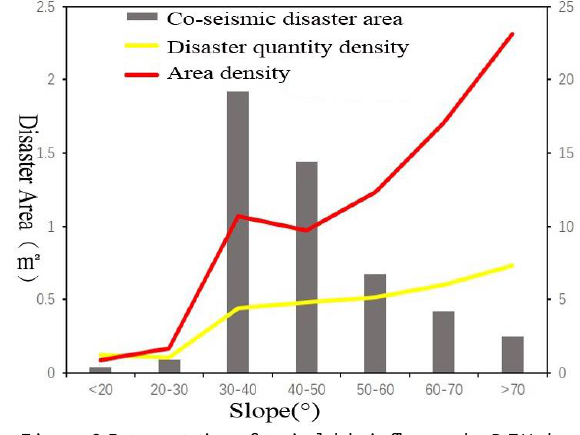
Figure. 8 Interpretation of typical debris flow under DEM by airborne LiDAR